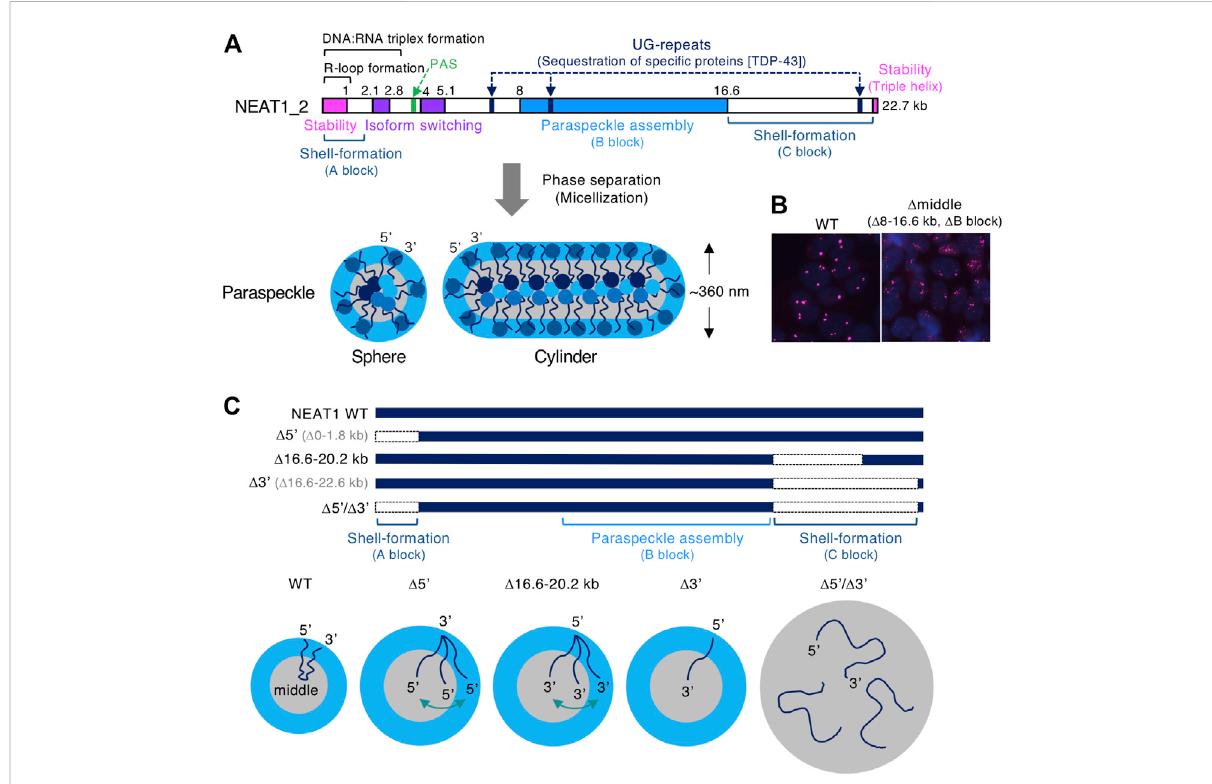
FIGURE 3 The functional RNA domains of human NEAT1 long non-coding RNA (lncRNA). (A) . Schematics show the domains of human NEAT1_2 lncRNA required for the form and function of paraspeckles. These domains include NEAT1_2 stability, isoform switching from NEAT1_1 to NEAT1_2, polyadenylation signal (PAS), UG-repeats that sequester TDP-43proteins,R-loopformation (Dumelie and Jaffrey, 2017),DNA:RNA triplex formation (Sentürk Cetin et al., 2019), paraspeckle assembly (B block), shell-formation (A and C blocks). The spherical and cylindrical paraspeckles with restricted size (Sx: ~360 nm in HeLa cells) form through micellization, a type of phase separation. (B) Deletion of the NEAT1_2 middle domain (8 – 16.6 kb region, B block) causes the formation of smaller paraspeckle foci (magenta). Nuclei are stained with DAPI (blue). (C) Schematics show NEAT1 mutants lacking the 5 ′ and/or 3 ′ domains (shell-forming domains) and the paraspeckles constructed by these mutants. Localization of NEAT1_2 within these paraspeckles and their size are